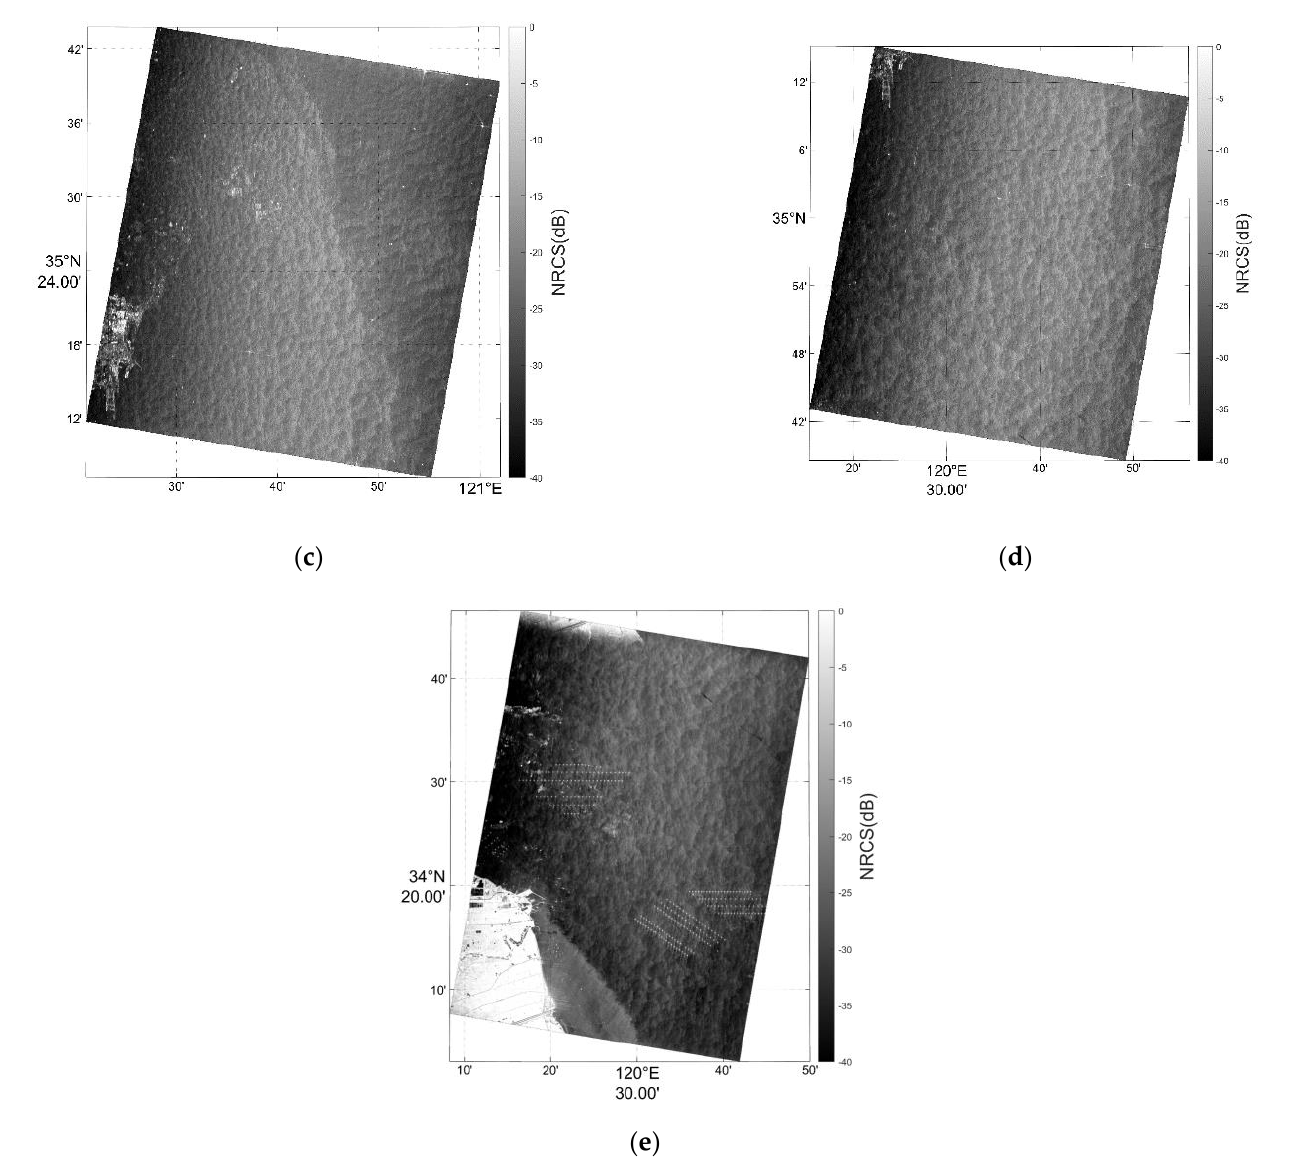
Figure 7. NRCS images of the five GF−3 ATI images acquired in Qing Dao. (a)~(e) are the NRCS of region a to region b in figure 1.